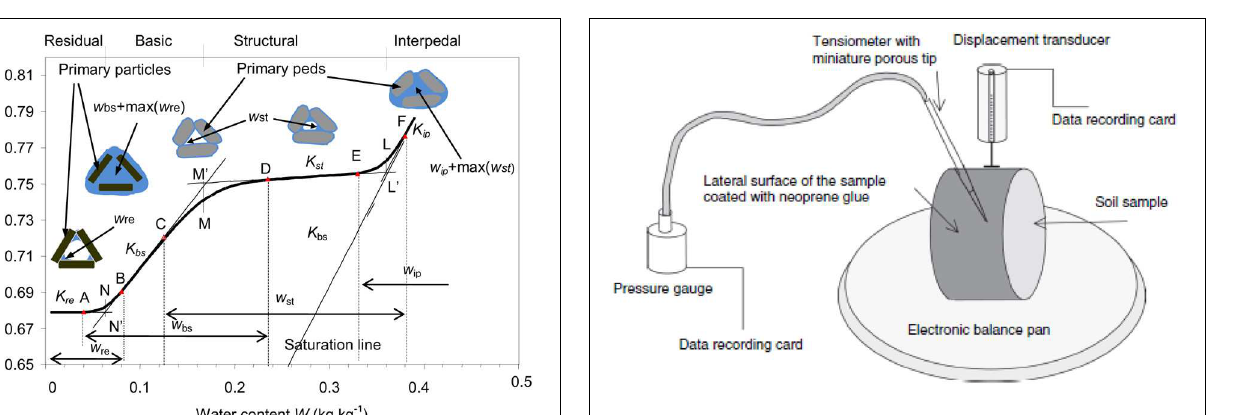
Hence, according to (1a) and (1b), W M is equal in value to